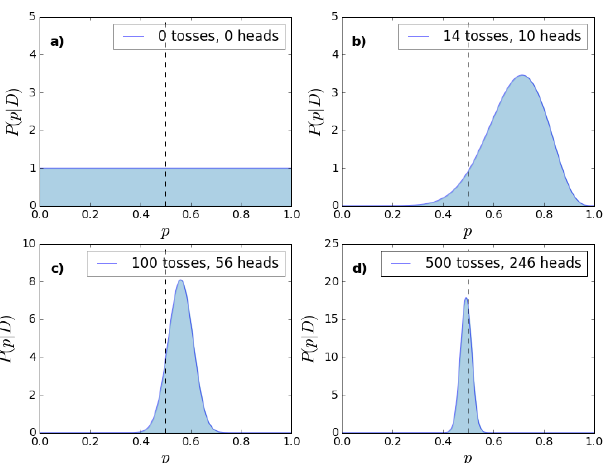
D ) , when: ( a ) there is no available data, ( b ) after 14 coin tosses Figure 2. Posterior distributions P ( p | of which 10 were heads, ( c ) after 100 coin tosses of which 56 were heads, ( d ) after 500 tosses of which 246 were heads. Notice that, while we continue increasing the experimental results, the posterior distribution starts to be more localized near by the real value p =